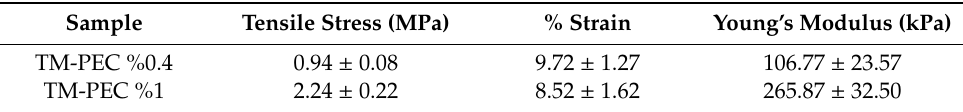
Table 3. Mechanical properties of the PEC